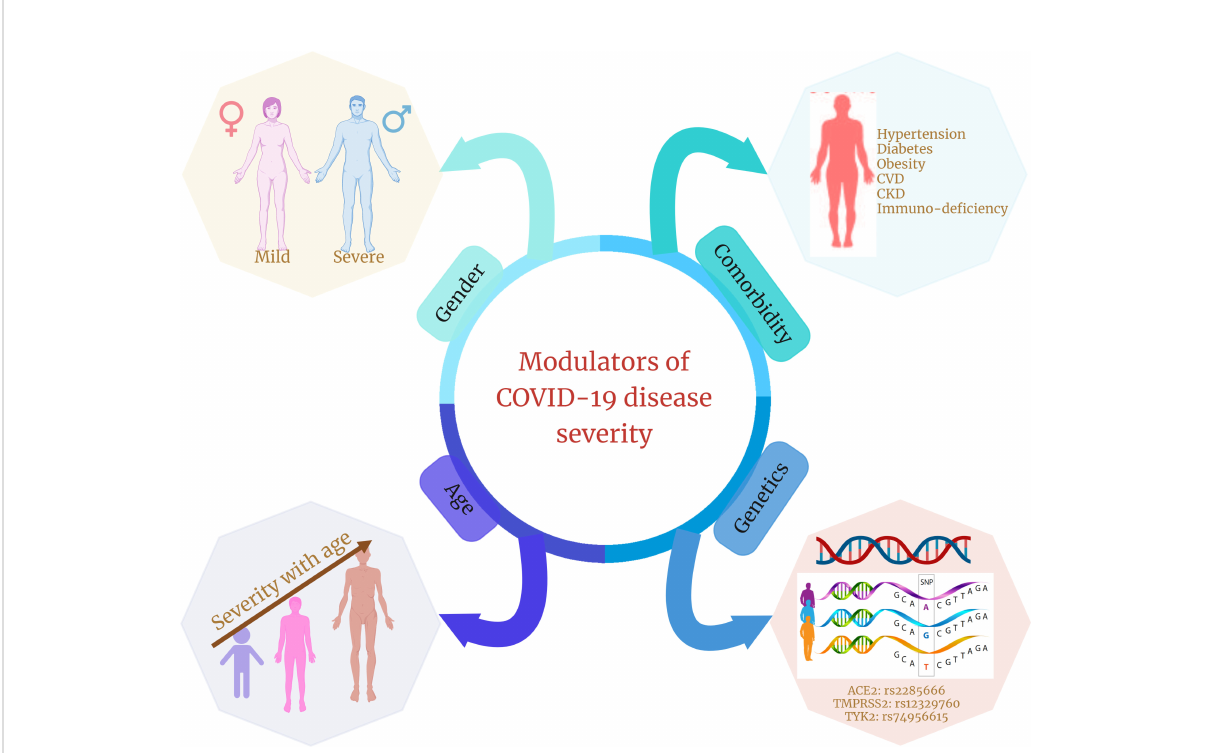
FIGURE 3 Different modulators of COVID-19 disease severity. Age, gender, presence of comorbidities, and genetic factors are four signi fi cant factors that are shown in multiple studies to modulate or are associated with COVID-19 disease severity and clinical